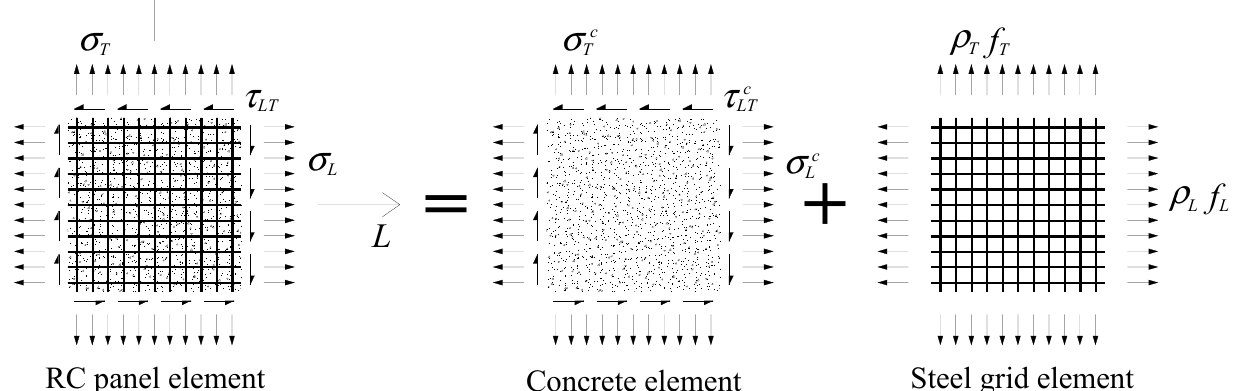
Figure 1. Reinforced concrete (RC) plate element under in-plane stresses.